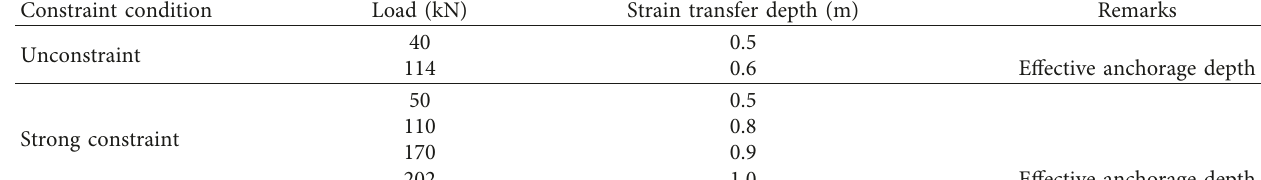
Table 3: Strain transfer depth under different constraint conditions.